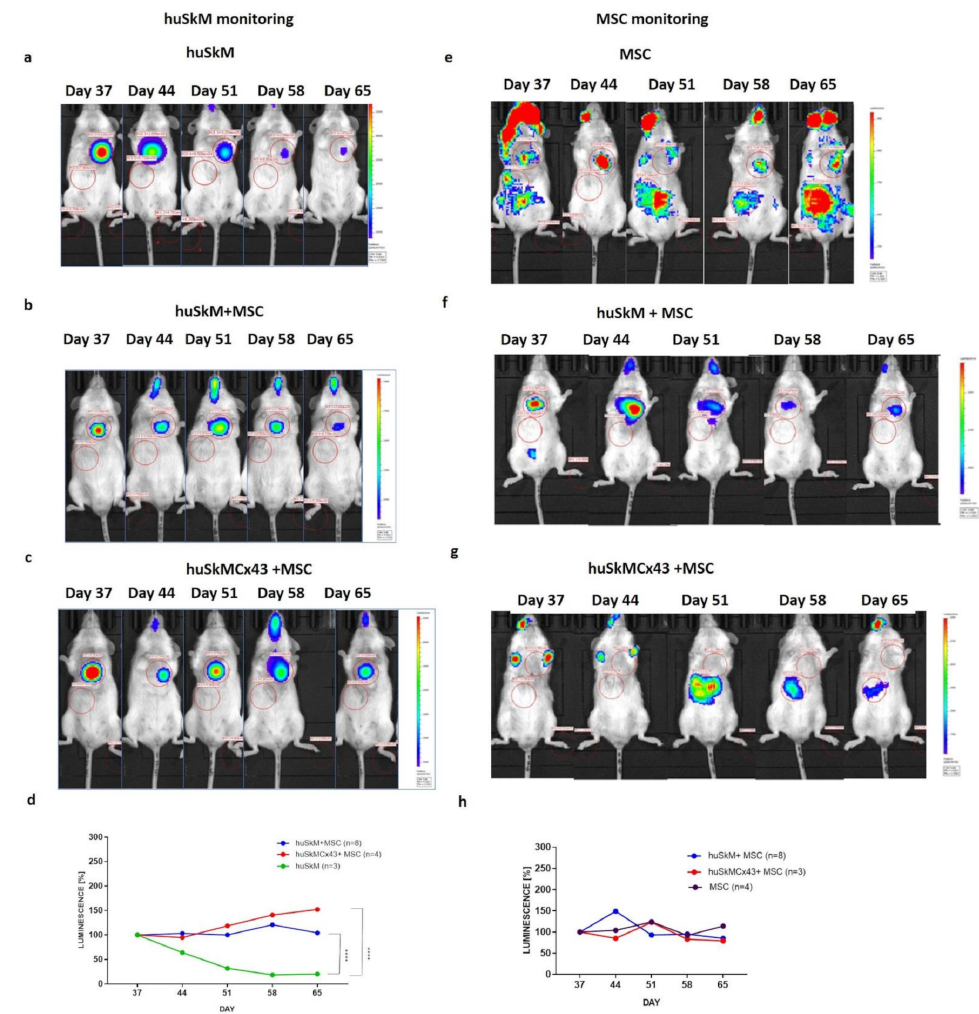
Figure 7. In vivo long-term monitoring of stem cells intramyocardially transplanted into a post- infarction mouse heart determined by bioluminescence imaging. Images were acquired on days 37, 44, 51, 58 and 65 of the experiment. Each image is displayed on a rainbow scale in units of photon radiance (s –1 cm –2 sr –1 ) and overlaid onto a greyscale reference image of the correspond- ing mouse. Representative images of firefly luciferase luminescence intensity in ( a ). huSkM, ( b ). huSkM + MSC and ( c ). huSkMCx43 + MSC. ( d ). The percentage (%) of firefly luciferase lumines- cence signal intensity in huSkM transduced with MSCV-fluc-GFP reporter vector on days 37, 44, 51, 58 and 65 of the experiment (post-infarction heart) plotted for huSkM ( n = 3), huSkM + MSC ( n = 8) and huSkMCx43 + MSC ( n = 4), (**** p < 0.0001, one-way Anova test followed by Tukey’s multiple com- parison test). Representative images of nanoluciferase luminescence intensity in MSCs transduced with EF-1-mkate-nanoluc reporter vector in ( e ). MSCs, ( f ). huSkM + MSC and ( g ). huSkMCx43+MSC. ( h ). The percentage (%) of nanoluciferase signal intensity in MSCs transduced with EF1-mkate- nanoluc reporter vector on days 37, 44, 51, 58 and 65 of the experiment (post-infarction hearts) plotted for MSCs ( n = 3), huSkM+MSC ( n = 8), and huSkMCx43 + MSC ( n = 4) (one-way Anova test followed by Tukey’s multiple comparison